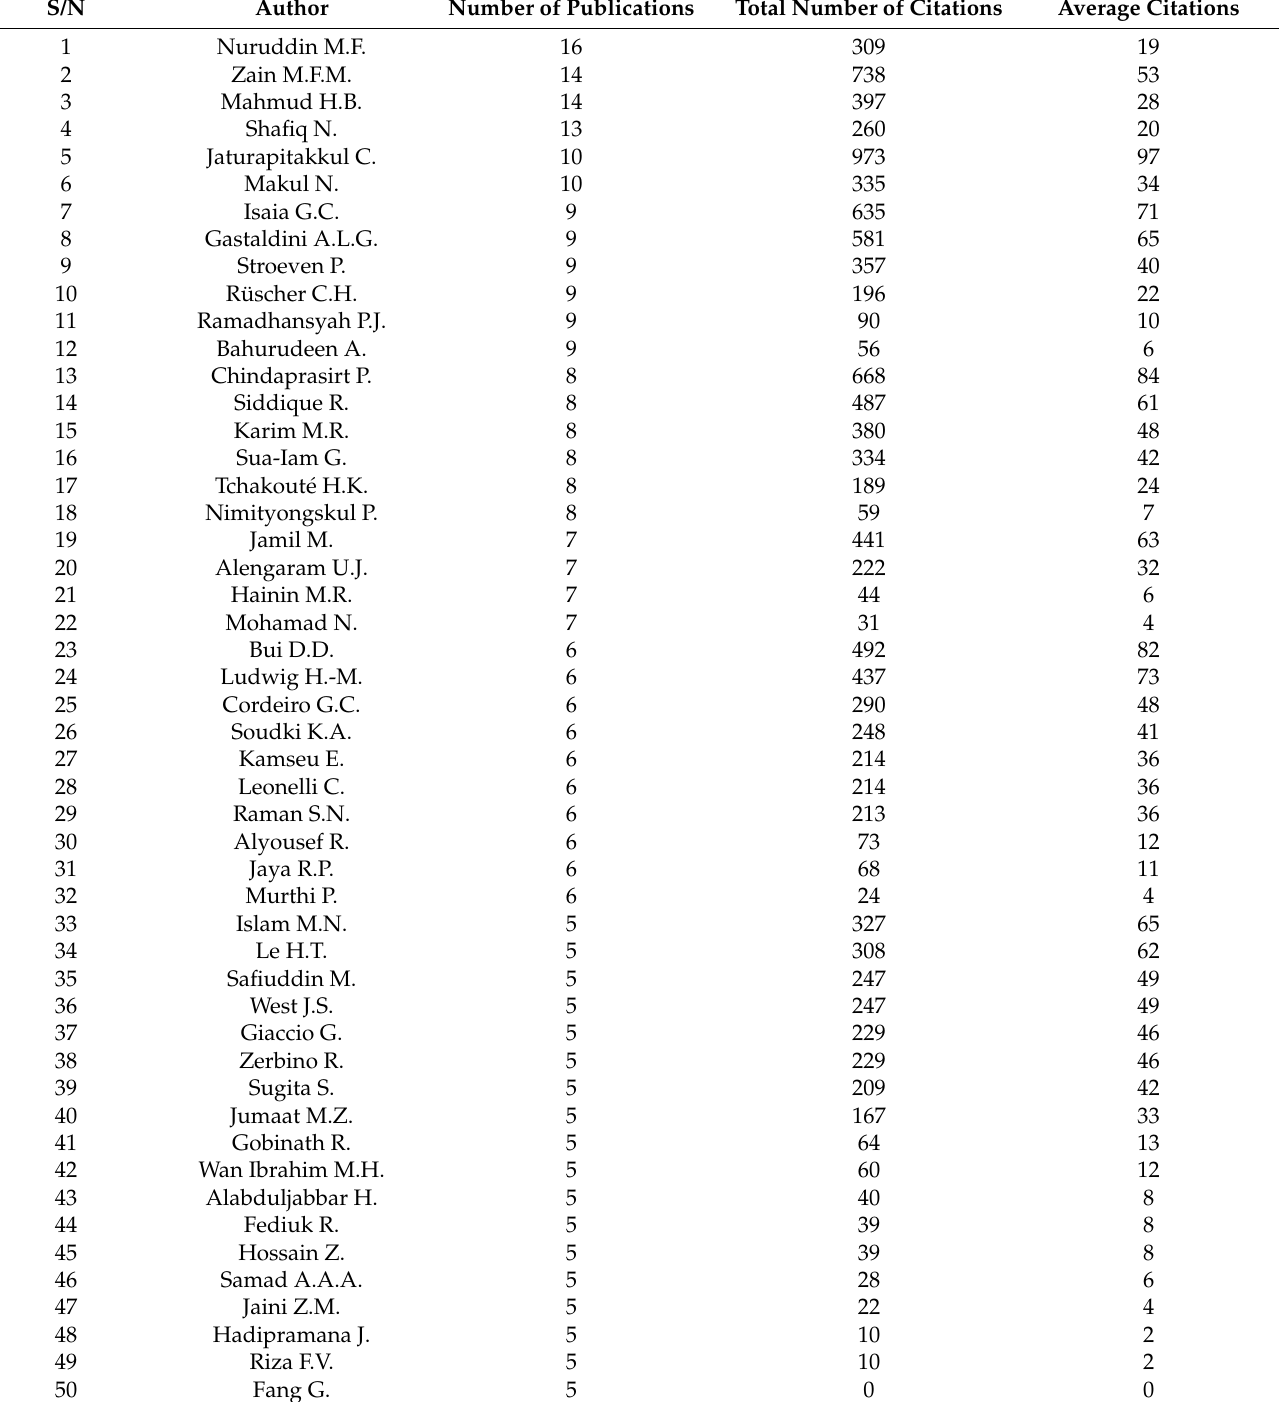
Table 3. Authors with at least five publications in the research of RHA concrete up to